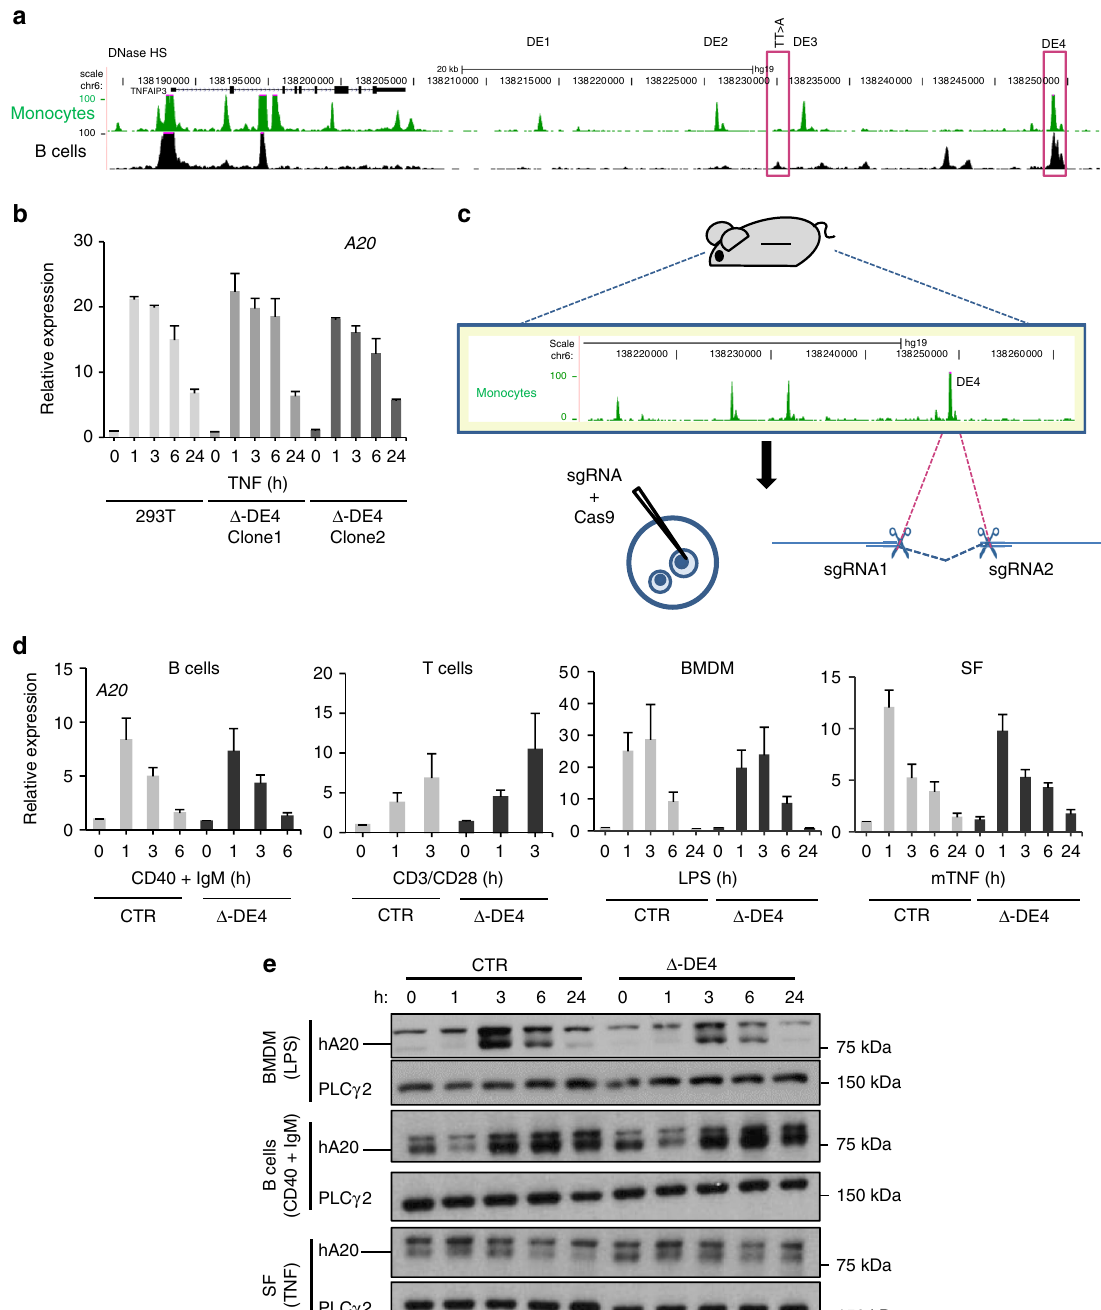
Fig. 4 Genome editing of DE4 enhancer and functional analysis in BAC transgenic mice. a Gene tracks showing genomic locations of downstream enhancers. b CRISPR-mediated deletion of downstream enhancer 4 (DE4) does not affect hA20 expression in 293T cells. qPCR analysis of hA20 mRNA in control and DE4-deleted 293T cells, error bars represent mean ± s.e.m. c Strategy of CRISPR-mediated deletion of DE4 in oocytes from hA20(CTR) mice. d qPCR analysis of hA20 mRNA in B cells, T cells, BMDM, and SF. Primary B cells were isolated from spleens, macrophages cultured from bone marrow (BMDM), and synovial fi broblasts (SFs) were isolated from ankle joints. B cells were stimulated with antibodies against CD40 (2 μ g ml − 1 ) and IgM (5 μ g ml − 1 ), BMDM with LPS (25 ng ml − 1 ), and SF with TNF (20 ng ml − 1 ) for the indicated times. Pooled data from three independent experiments with three different Δ -DE4 mouse lines is shown. Error bars indicate mean ± s.e.m., statistical signi fi cance was determined using one-way ANOVA followed by Tukey ’ s multiple comparison test. e Immunoblot analysis of hA20 protein expression in primary cells obtained and stimulated as in d . Representative of two independent